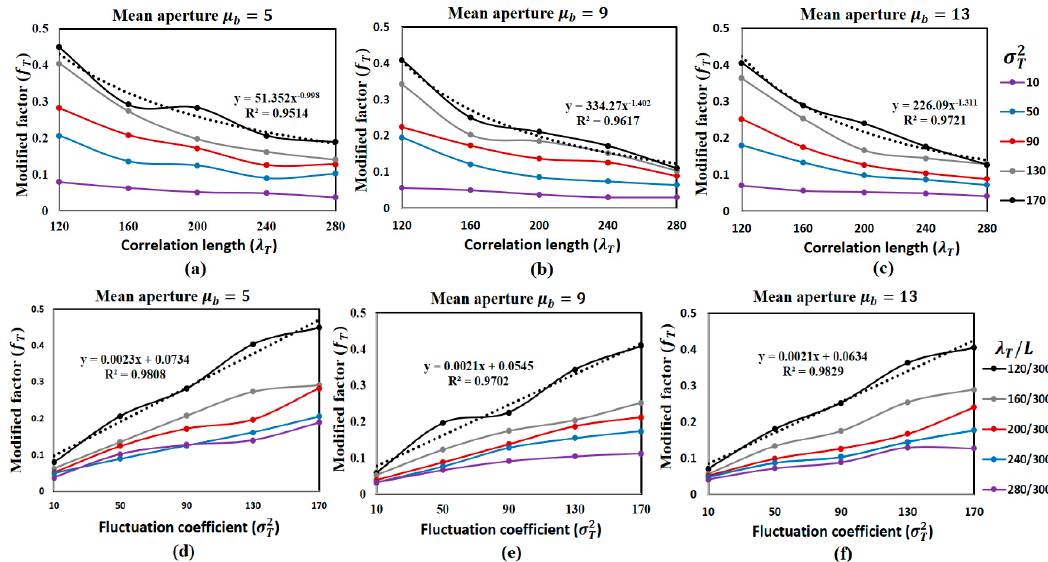
Figure 8. Relationships between the modified factor ( f T ) and the correlation lengths ( λ T ) of (a–c) and the undulation coefficients ( σ T2 ) of (d–f) for three groups of fracture models of respective mean apertures of 5, 9, and 13 (in voxels), in which model parameters σ b2 = 0, λ b = ∞ are fi xed. Where L presents the size (in voxels) of fracture models in X or Y direction. The black dotted lines are the fitting curves for the data lines for models of σ T2 = 170 or λ T /L = 120/300. The symbol R 2 denotes the extent of the curves fitting the data.